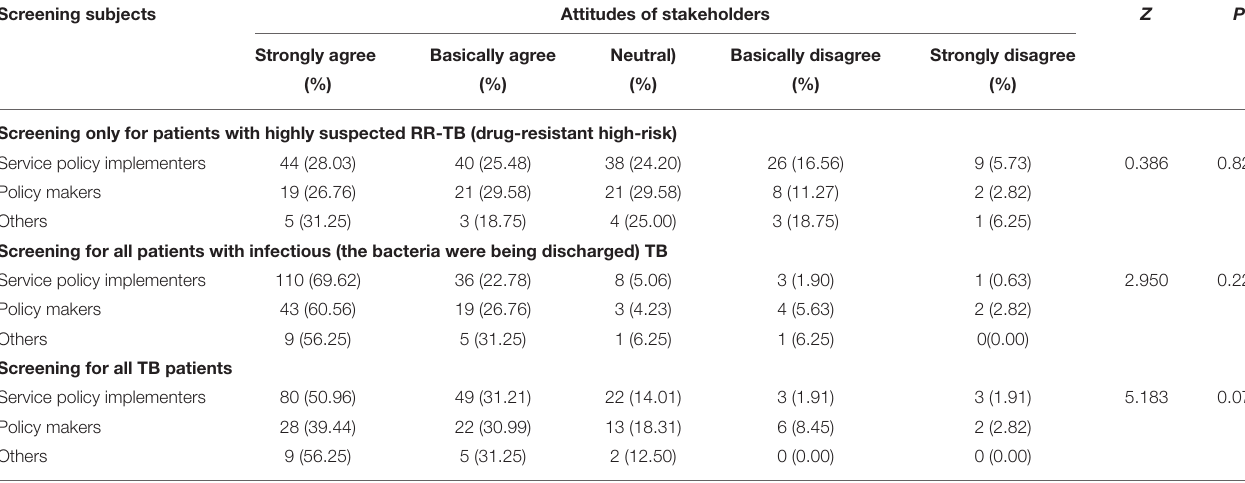
TABLE 5 | Attitudes of different categories of stakeholders among service providers toward RR-TB screening subjects. Screening subjects